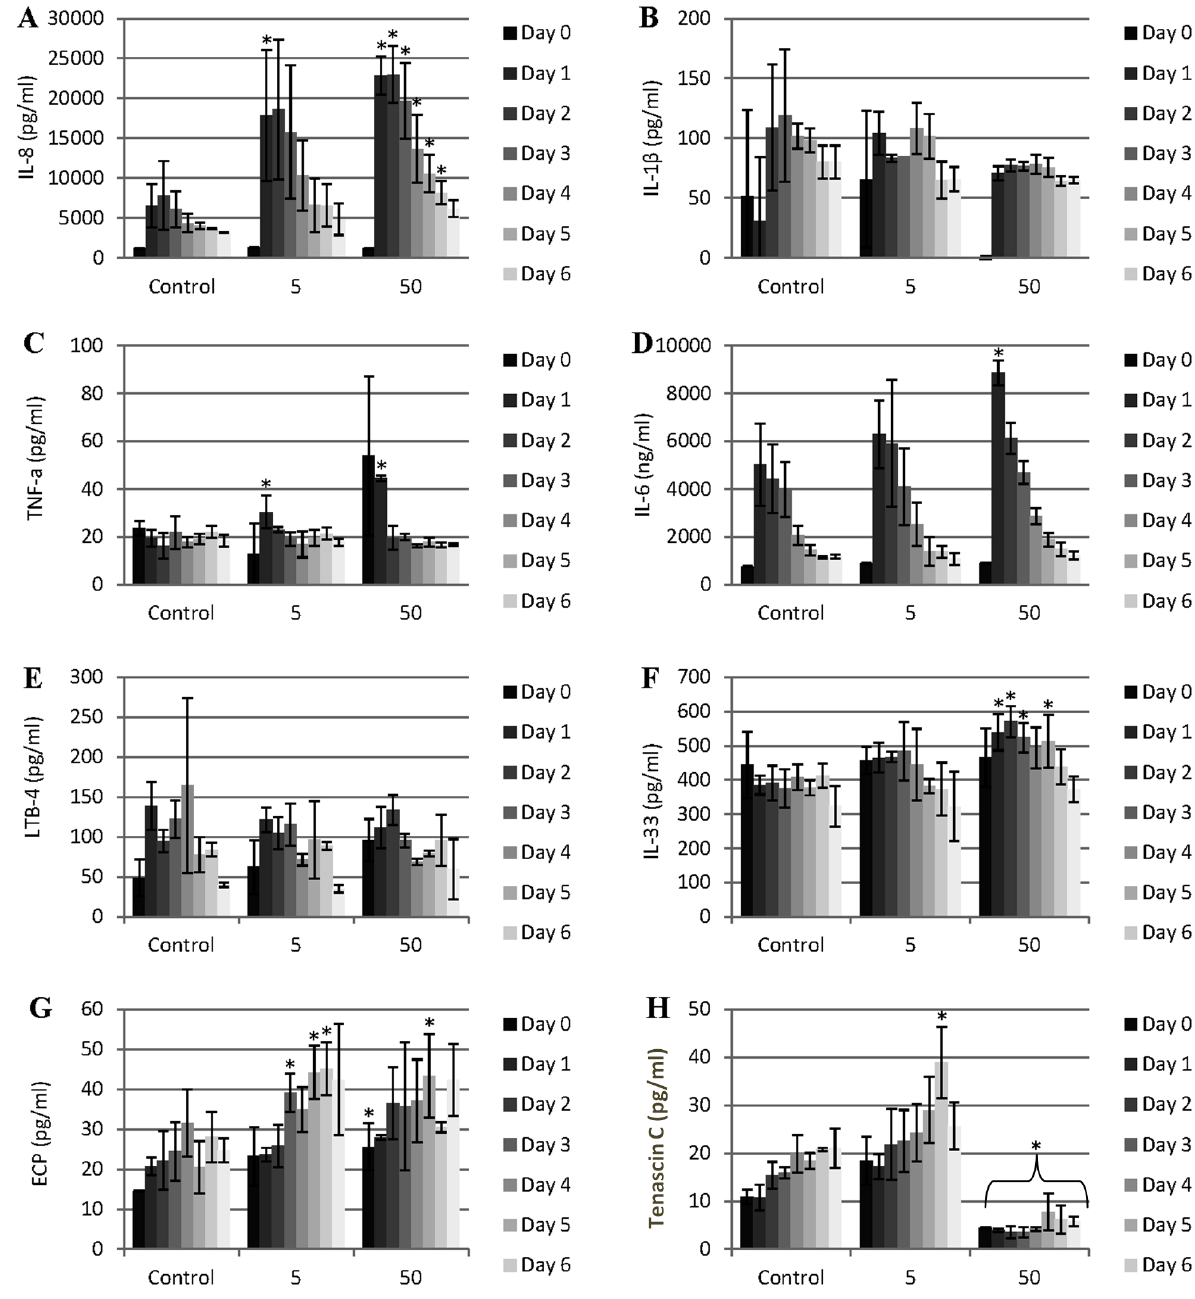
Figure 4. Pattern of cytokine and other mediator release during the exposure of porcine dura mater to CoCr nanoparticles for a period of 0–7 days. The dura mater organ culture was exposed to estimated doses of 0 (control), 5 and 50 µm 3 of CoCr nanoparticles per epithelial cell. The factors that were investigated were IL-8 ( A ), IL-1 β ( B ), TNF- α ( C ), IL-6 ( D ), LBT-4 (leukotriene B4) ( E ), IL-33 ( F ), ECP (eosinophil chemotactic protein, eotaxin, CCL-11) ( G ), and tenascin C ( H ). Data is expressed as the mean ( n = 3) ±95% confidence limits. Data were analysed by one-way analysis of variance and individual differences between group means determined by the T-method. * indicates significantly difference between control and CoCr-treated tissue (* p <